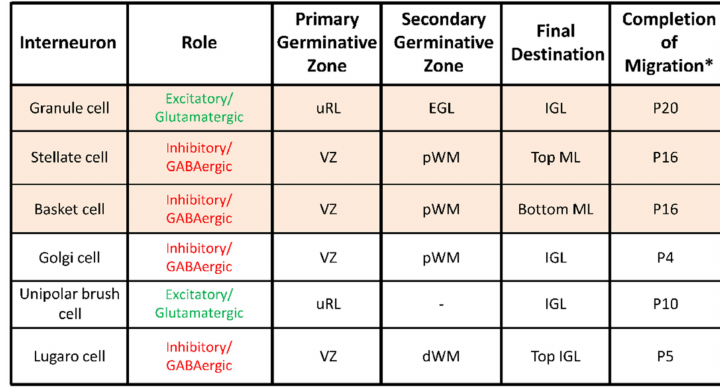
Figure 2. Characteristics of migrating interneurons in the postnatal cerebellum. dWM, deep white matter; pWM, prospective white matter; uRL, upper rhombic lip; EGL, external granular layer; ML, molecular layer; PCL, Purkinje cell layer; IGL, internal granular layer; VZ, ventricular zone; P20, postnatal day 20. * in mouse or